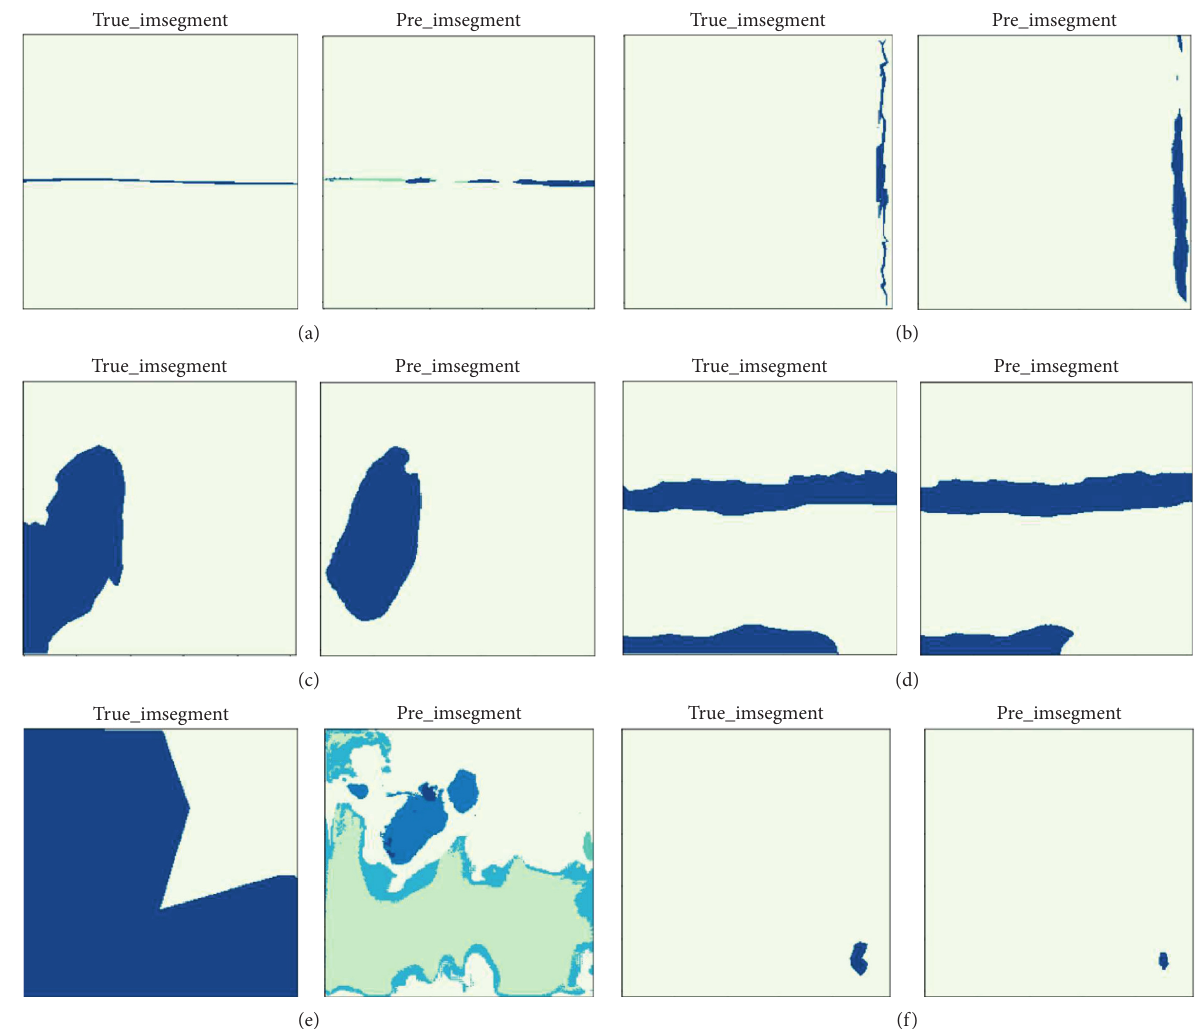
Figure 7: Examples of empirically determined and predicted labels. (a) Transverse crack. (b) Longitudinal crack. (c) Alligator crack. (d) Patch. (e) Block crack. (f)